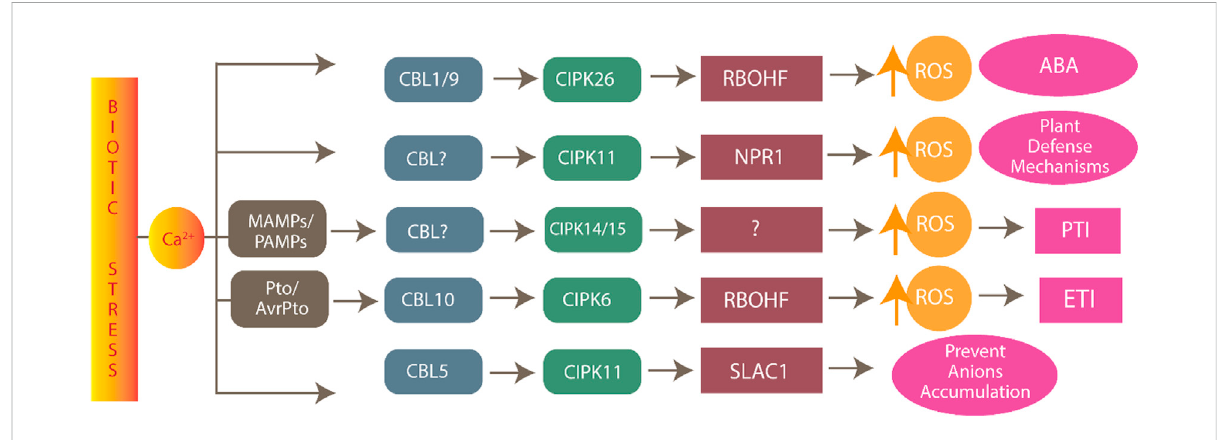
FIGURE 7 CBL-CIPK complexes involved in response to biotic stress in